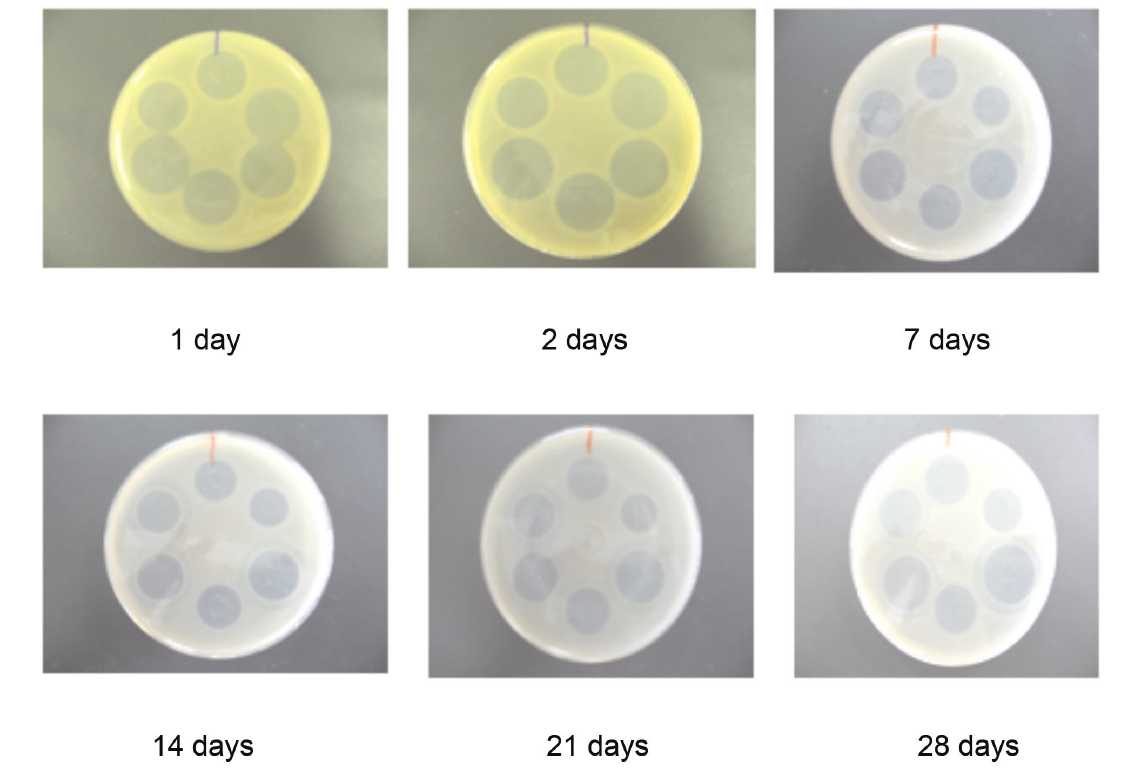
FIGURE 6 - Zone diameters for the azithromycin under UV light (284 nm) exposition.